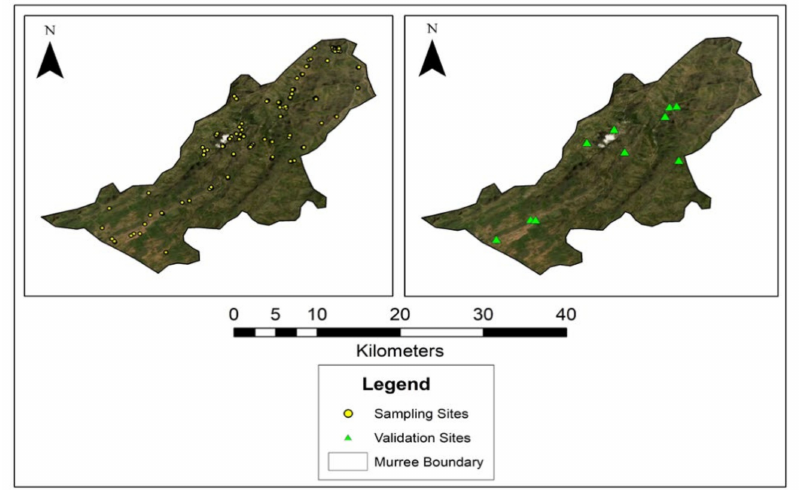
Figure 3. Sampling sites map and validation sites map (locations of the